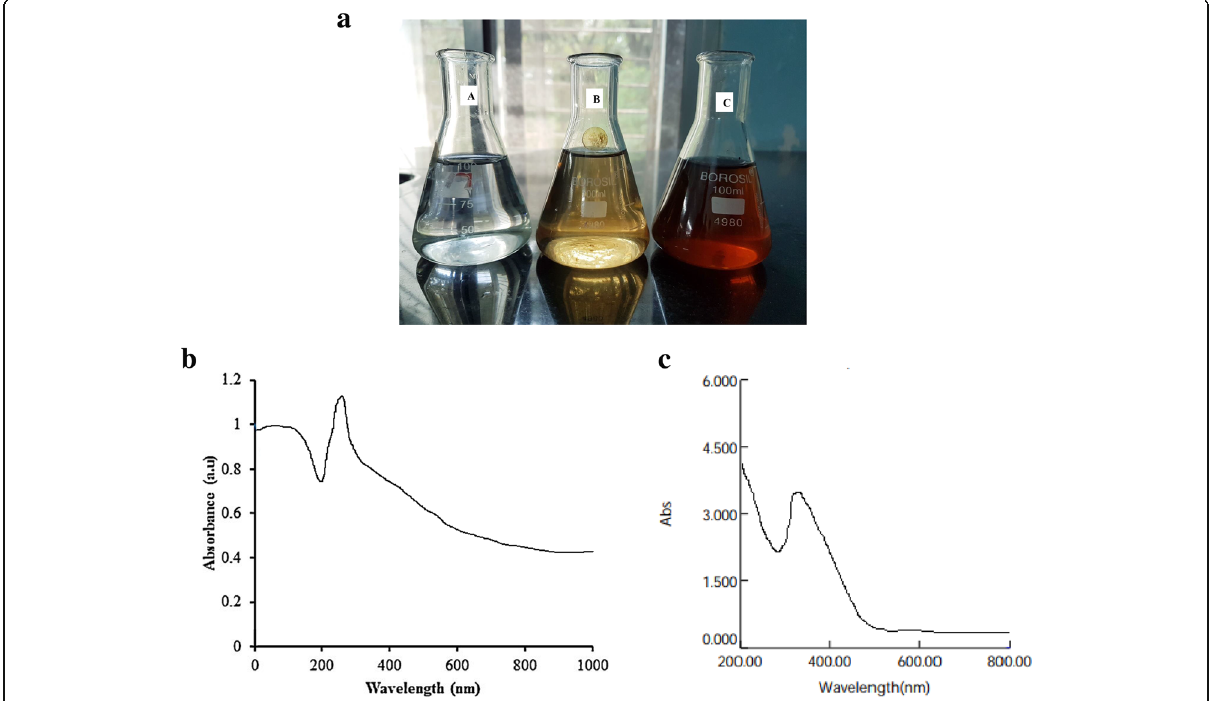
Fig. 1 a A: magnesium nitrate solution, B: before the synthesis of nanoparticles, C: after synthesis of nanoparticles. b UV-Visible spectrophotometric analysis of biosynthesized magnesium oxide nanoparticles. c UV-Visible spectrophotometric analysis of Pterocarpus marsupium heartwood